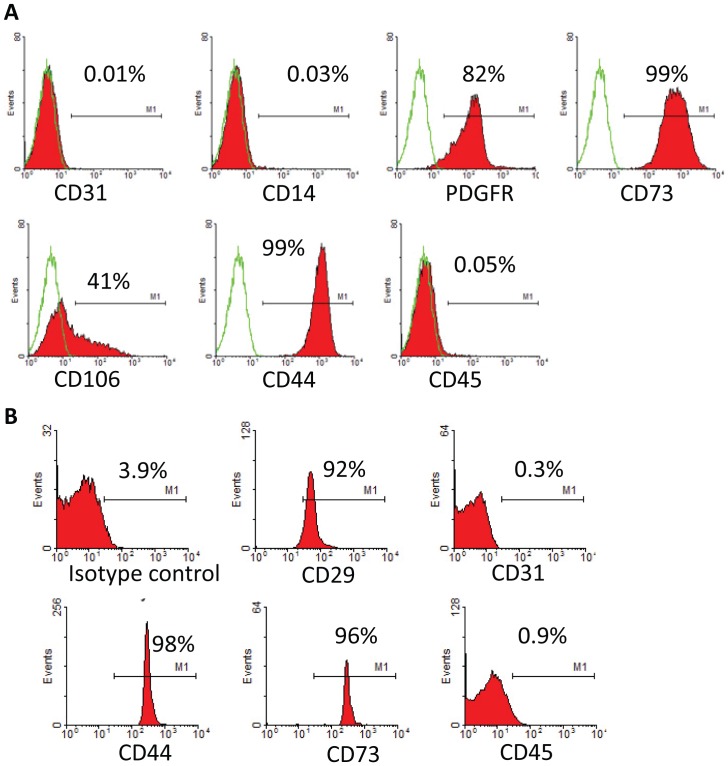
Flow cytometric characterization of MSC and MV.A. Detection of MSC-specific marker expression of UMSC by flow cytometric analysis. B. Identification of MSC-MVs by bead-based flow cytometry.